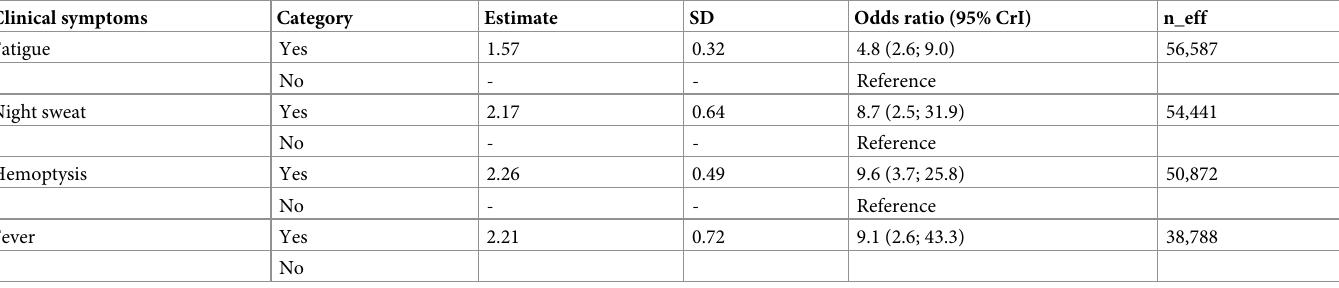
Table 3. Clinical symptoms significantly associated with human tuberculosis in the Bayesian mixed-effects multivariable logistic regression model. Clinical